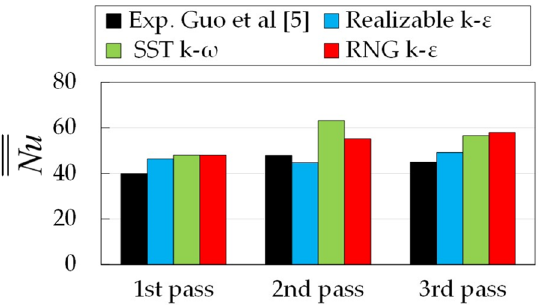
Figure 12. Comparisons of globally averaged Nusselt number in each pass for different turbulence models at Re = 10,000.